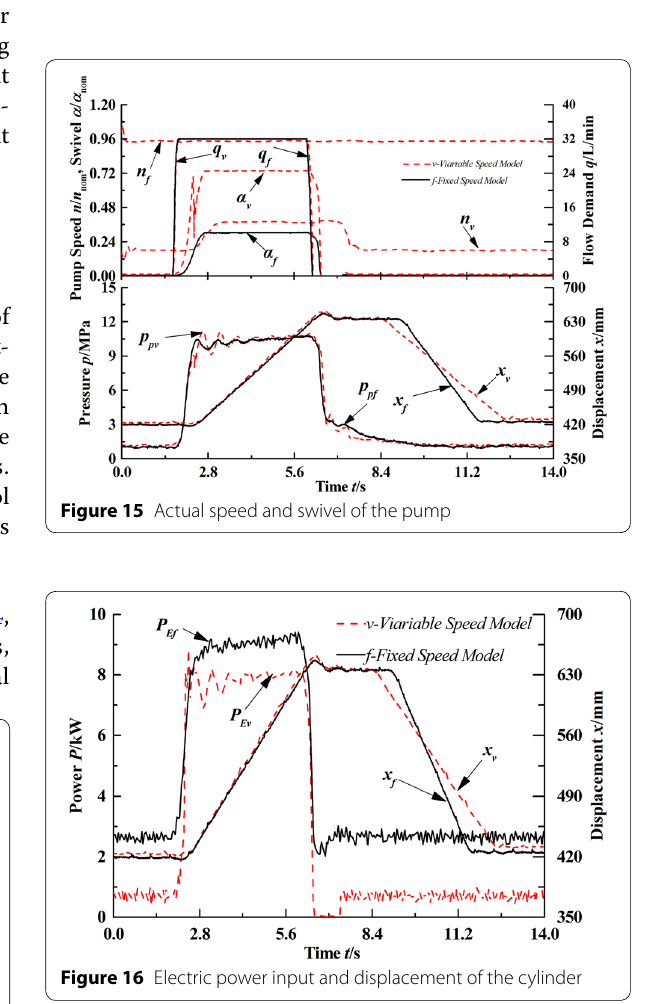
Figure 14 Electric power input and displacement of the cylinder